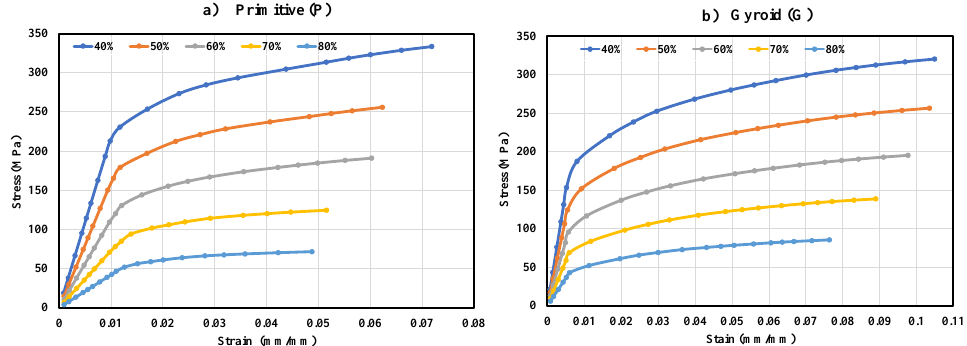
Figure 7. G Stress-strain diagram for 2 × 2 × 2 lattice size of porosities ranging from 40% to 80% ( a ) P lattice ( b ) G lattice.